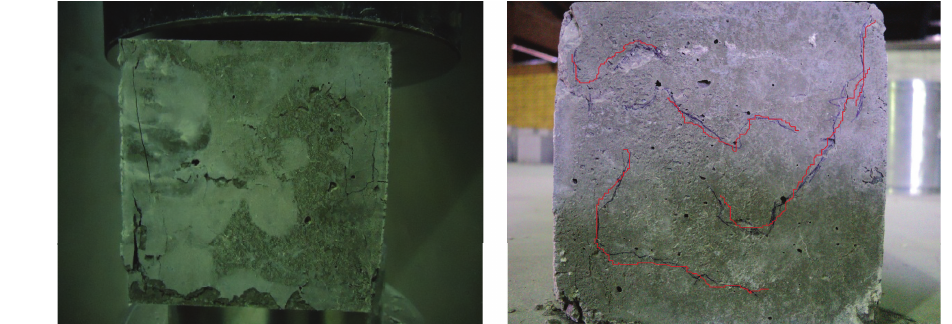
Figure 7: Breaking cubic samples.